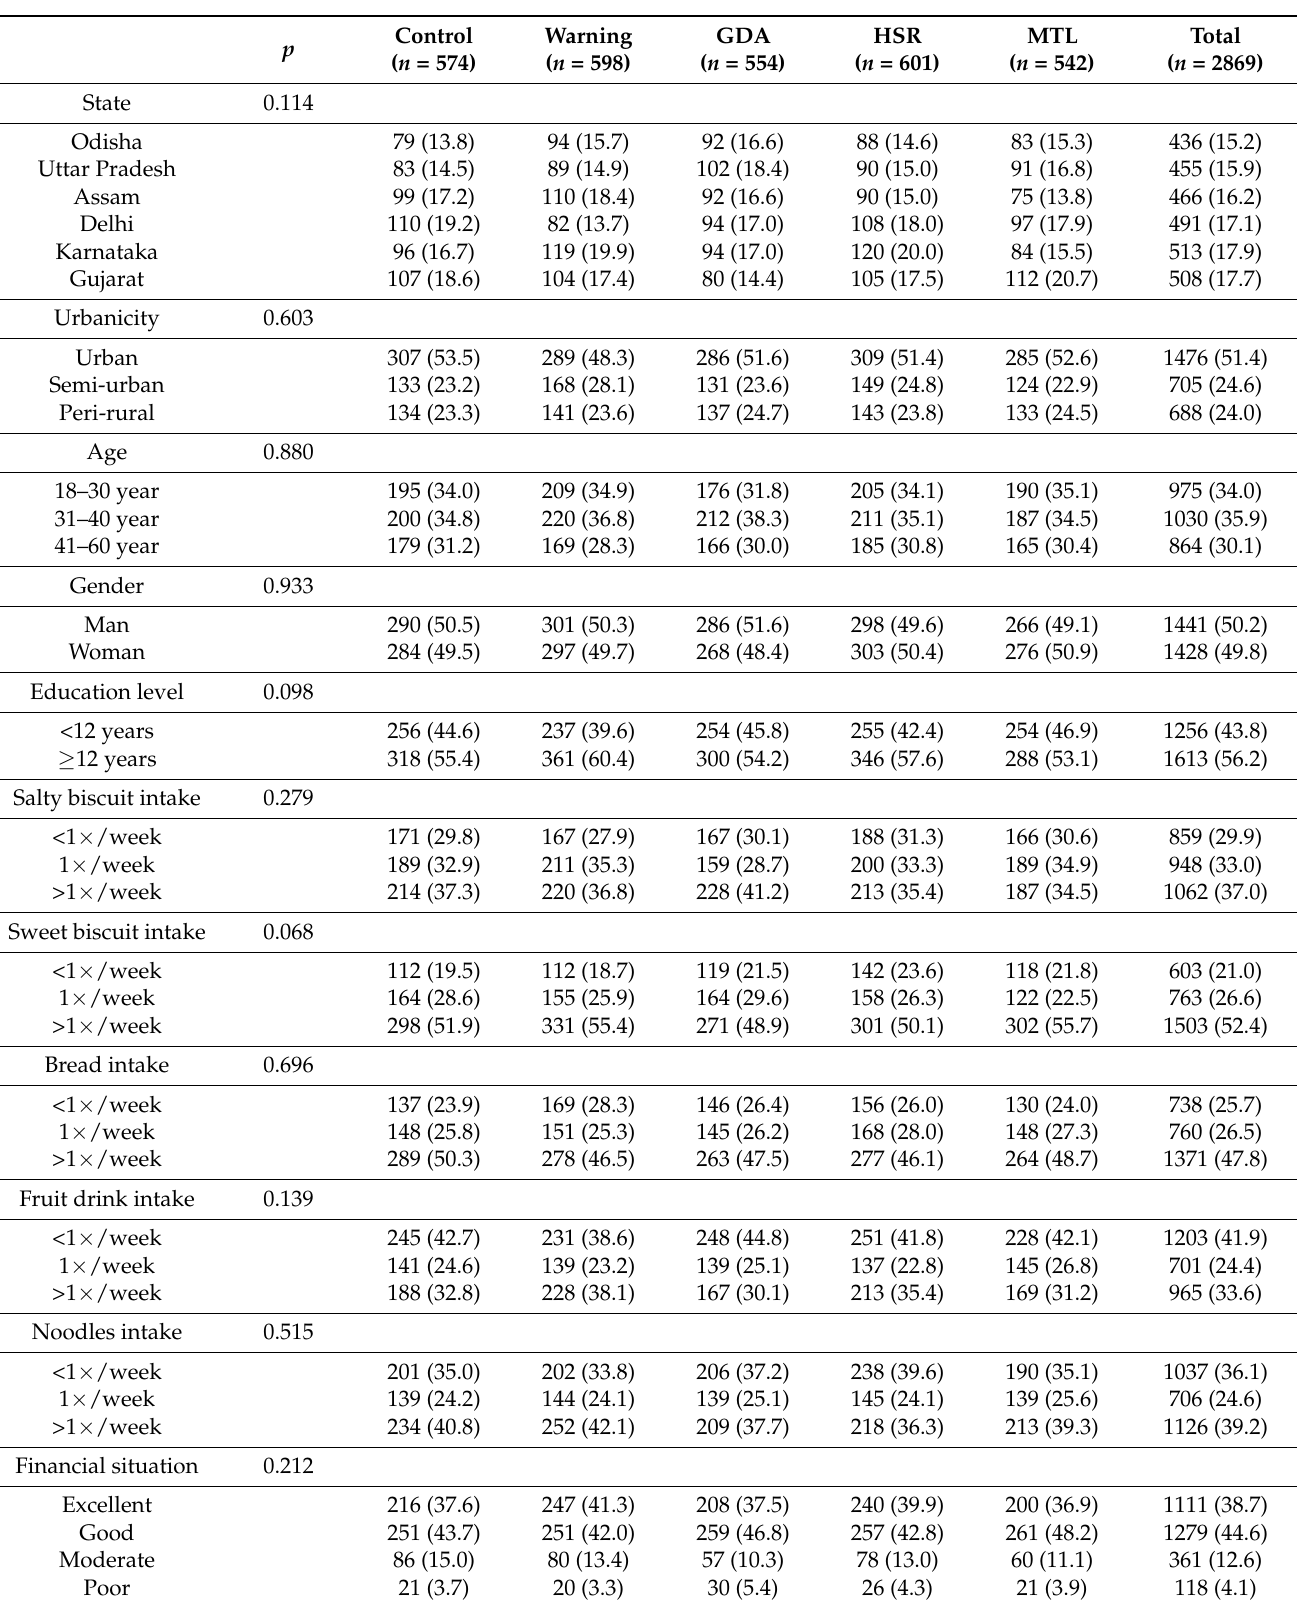
Table 1. Socio-demographic characteristics of the sample, n